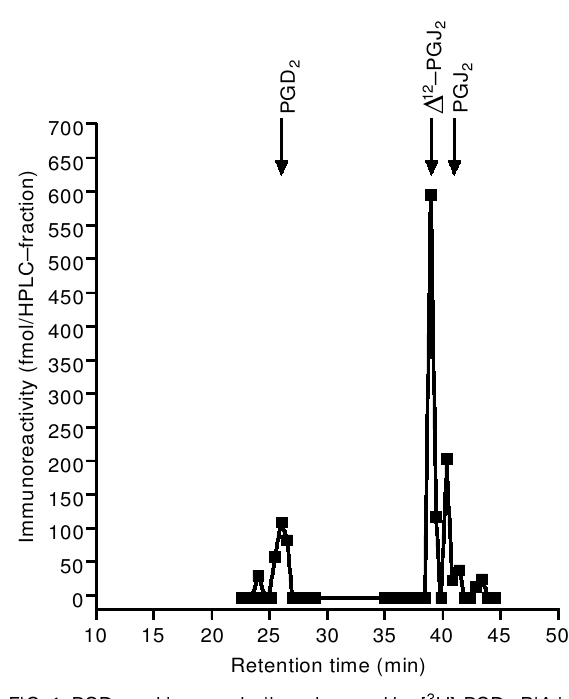
FIG. 1. PGD 2 and its metabolites detected by [ 3 H]-PGD 2 -RIA in HPLC fractions of a supernatant of BMMC. BMMC were stimulated with calcium ionophore A23187 (0.2 m M). Super- natants were separated by HPLC and HPLC-fractions were analysed by RIA. Retention times of authentic PGD 2 , PGJ 2 and D 12 -PGJ 2 standards are indicated by arrows.